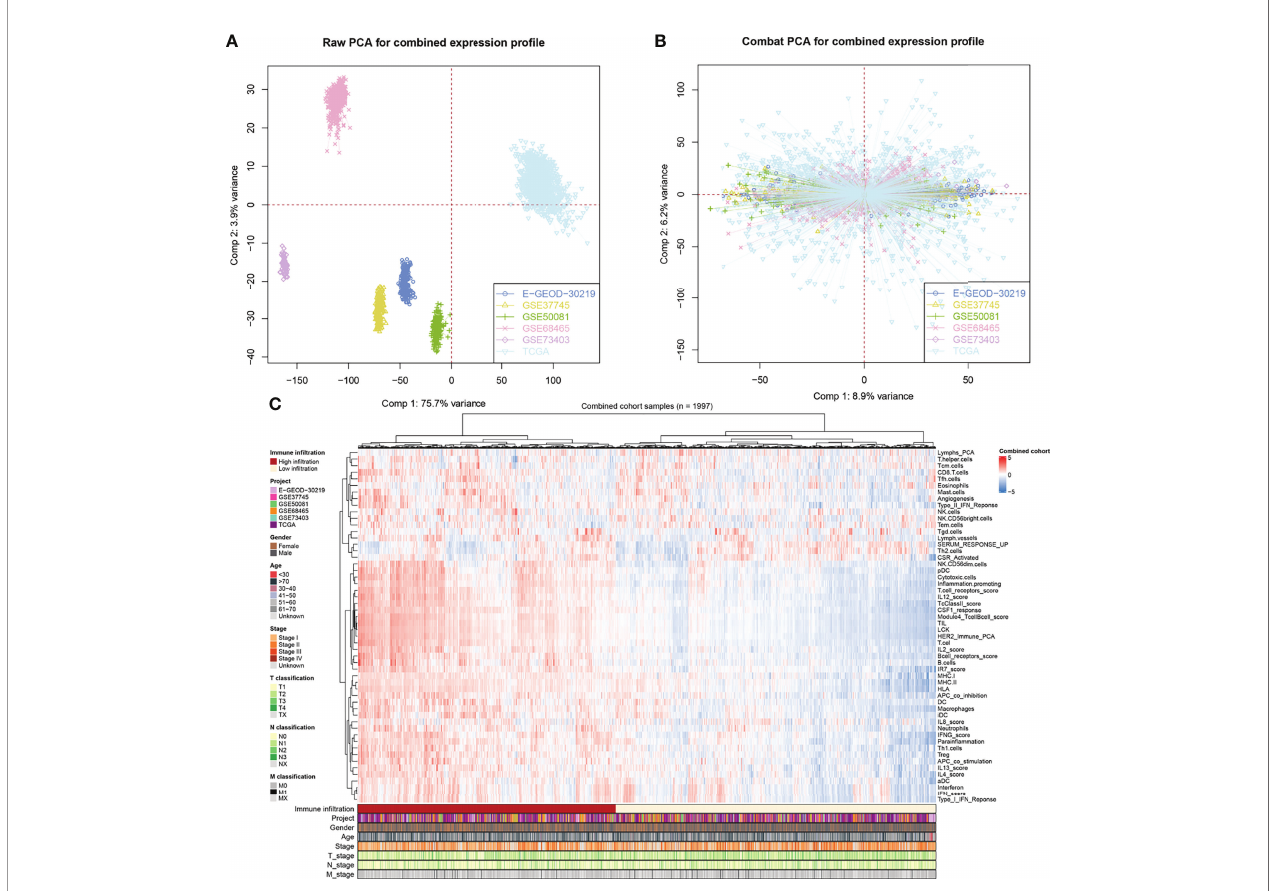
FIGURE 2 | Combination of NSCLC cohort and quanti fi cation of immune terms. (A, B) The sva package was used for reduce the batch difference of individual cohort, including TCGA, GSE73403, GSE68465, GSE50081, GSE37745 and E-GEOD-30219; (C) ssGSEA algorithm was used to quantify the 53 immune terms based on the transcript